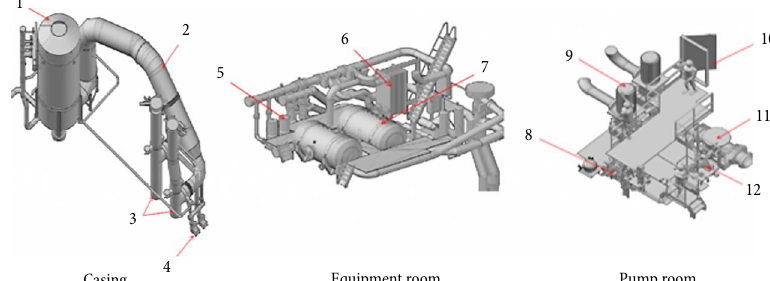
Fig. 1. The scrubber system elements: 1 – scrubber; 2 – exhaust manifold; 3 – existing exhaust pipe; 4 – sealing air